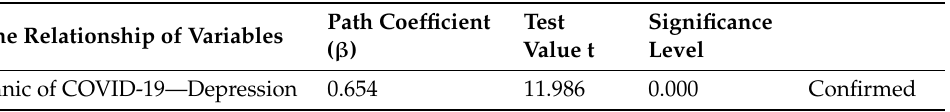
Table 13. Evaluation indicators of the internal model of the research, direction and significance of direct